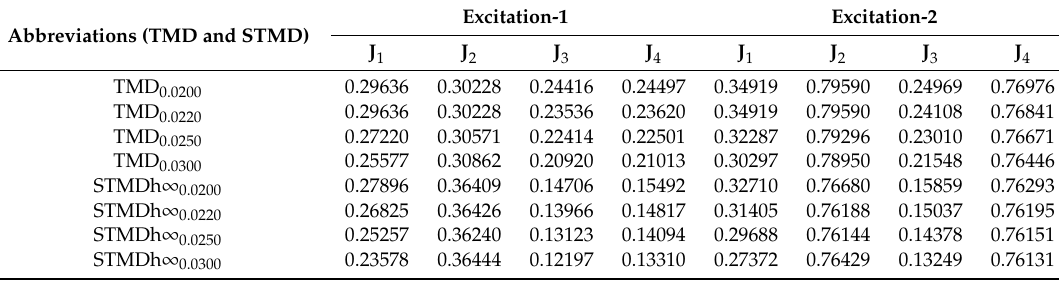
Table 5. Evaluations of the STMDh ∞ and the TMD according to the performance